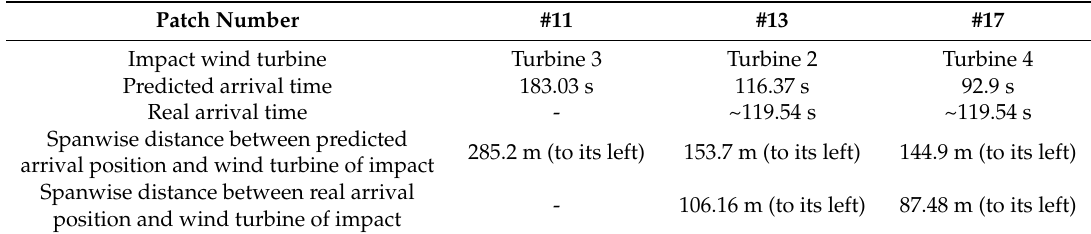
Table 2. Predicted and real arrival time and position of